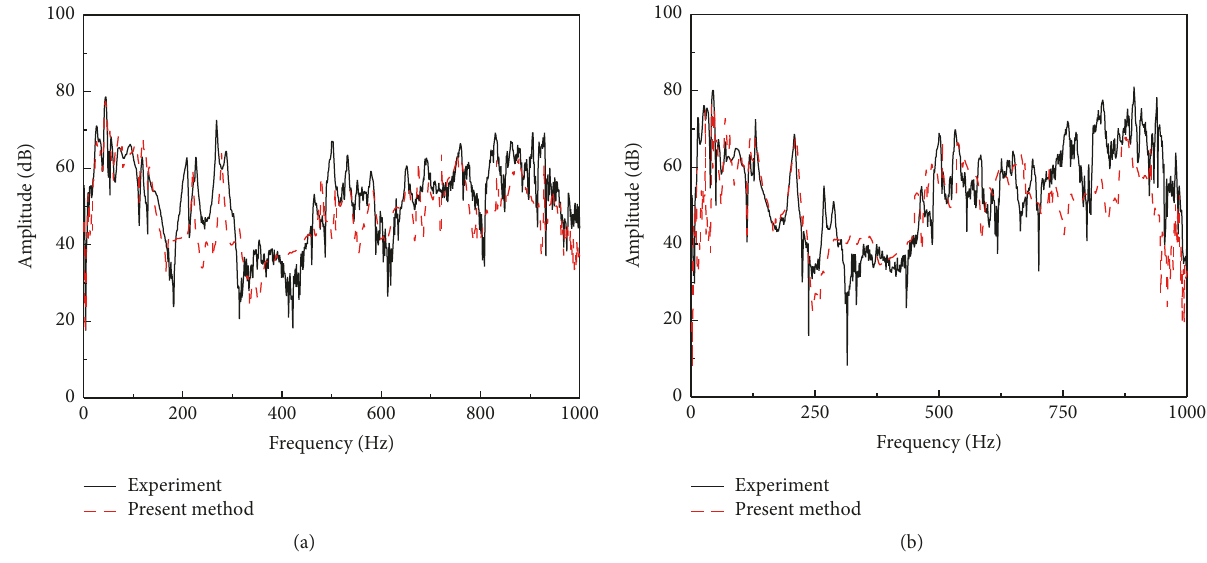
Figure 9: Comparison of the measured FRFs and the synthesis results for floating raft system with attached pipes: (a) transfer FRF from exciting point to point 1; (b) transfer FRF from exciting point to point 2.